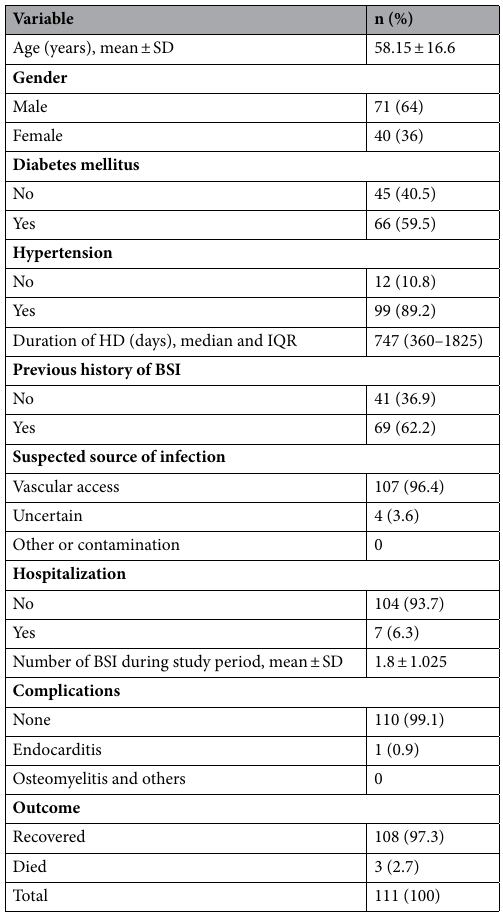
Table 1. Demographic and clinical characteristics of HD patients who had BSI (111 patients). BSI bloodstream infection, HD hemodialysis, IQR interquartile range, SD standard